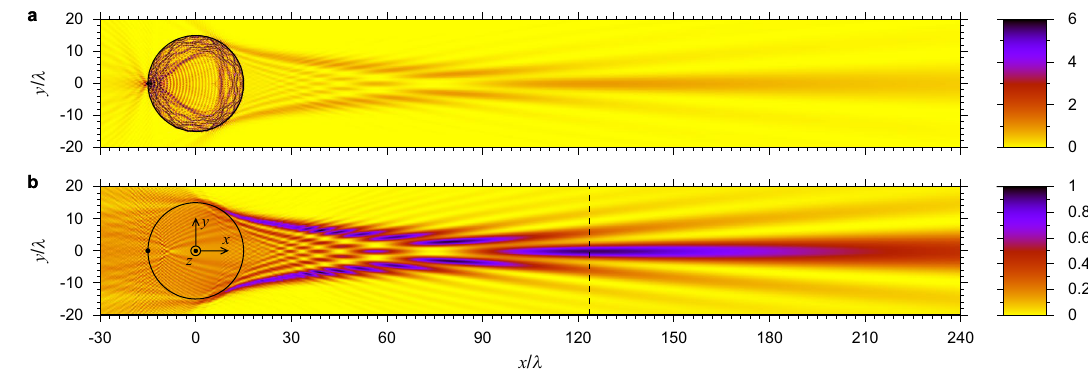
2 and ( b ) 1 : ( a ) E z ( x , y ) | | = 0 . In 124 , y = = 124 defines the =